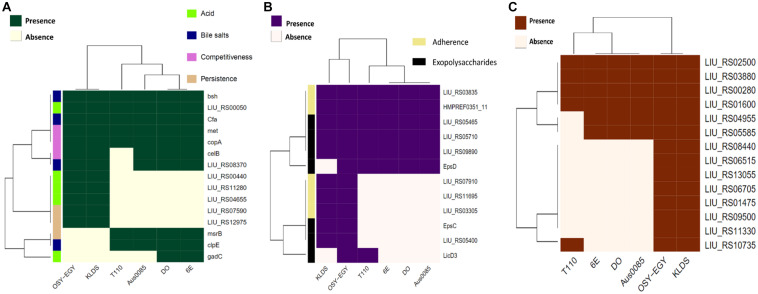
Heatmap showing the clustering of the compared Enterococcus spp. genomes based on the presence of (A) genes associated with survival in the GIT, (B) genes associated with adherence to the GIT, and (C) genes associated with antioxidant activity.